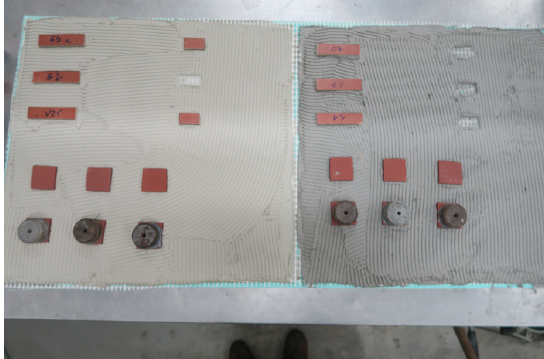
Figure 3: Preparing the stand to measure an adhesion